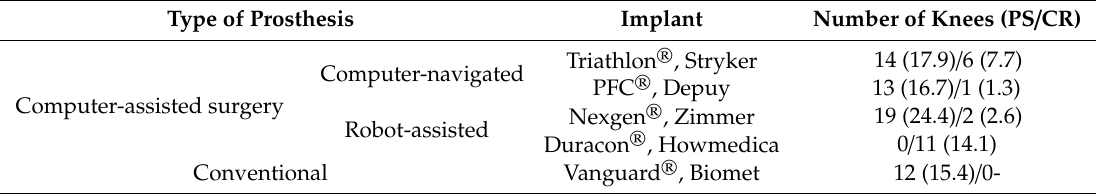
Table 2. The types of prosthetic components used.